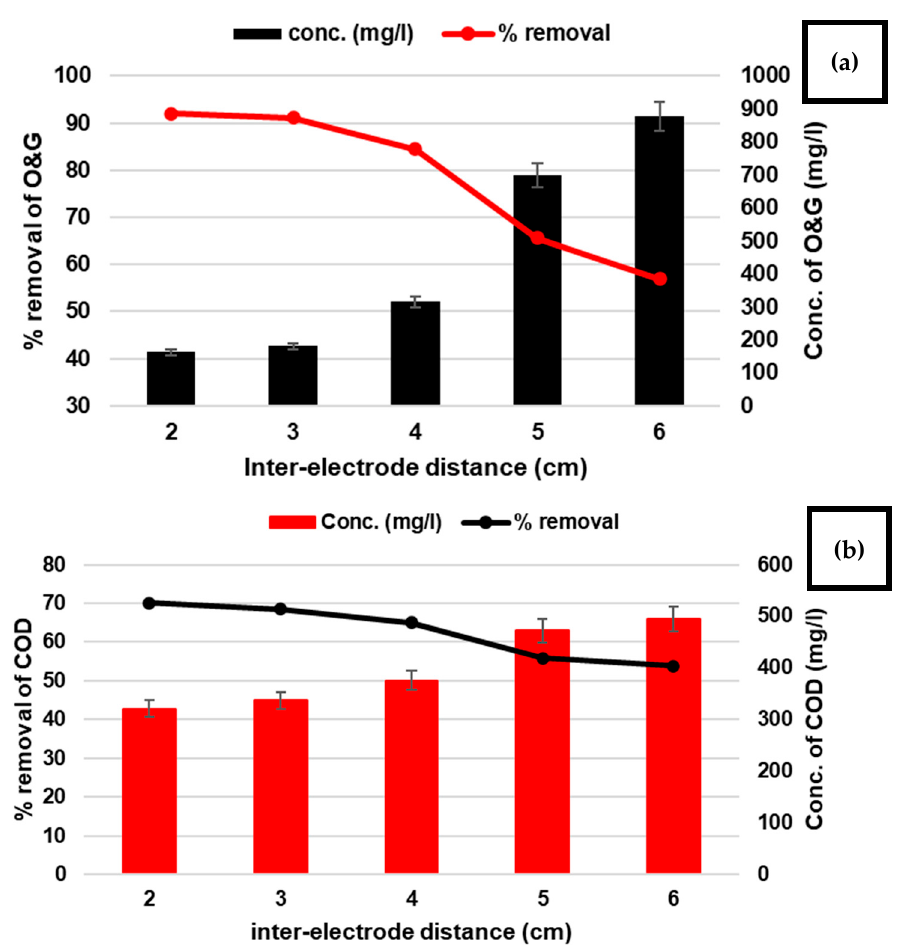
Figure 3. The effect of ID on the (%) removal efficiency and concentration of ( a ) O&G and ( b ) COD using the EC process with a constant electrolysis time of 20 min and 50 A/m 2 current density.